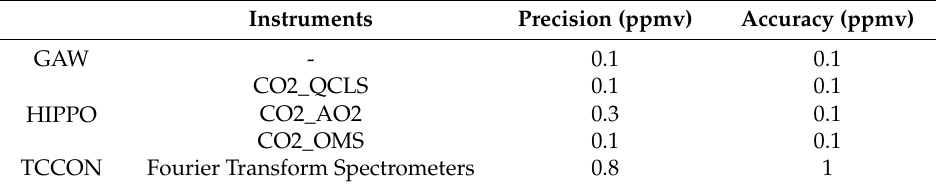
Table 4. Precision and accuracy of highly accurate CO 2 measurements (Unit 1 :